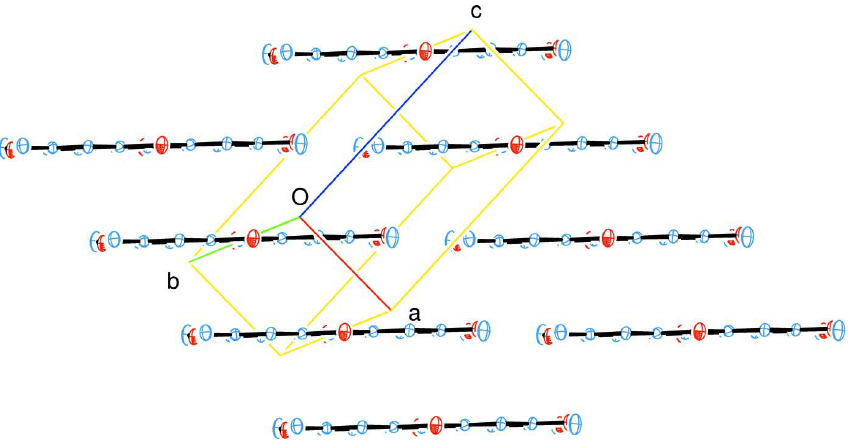
The molecular structure of the title compound (I), showing the atomic numbering numbering and 30% probability displacement ellipsoids. Symmetry code: (i) - x , - y + 1, - z .